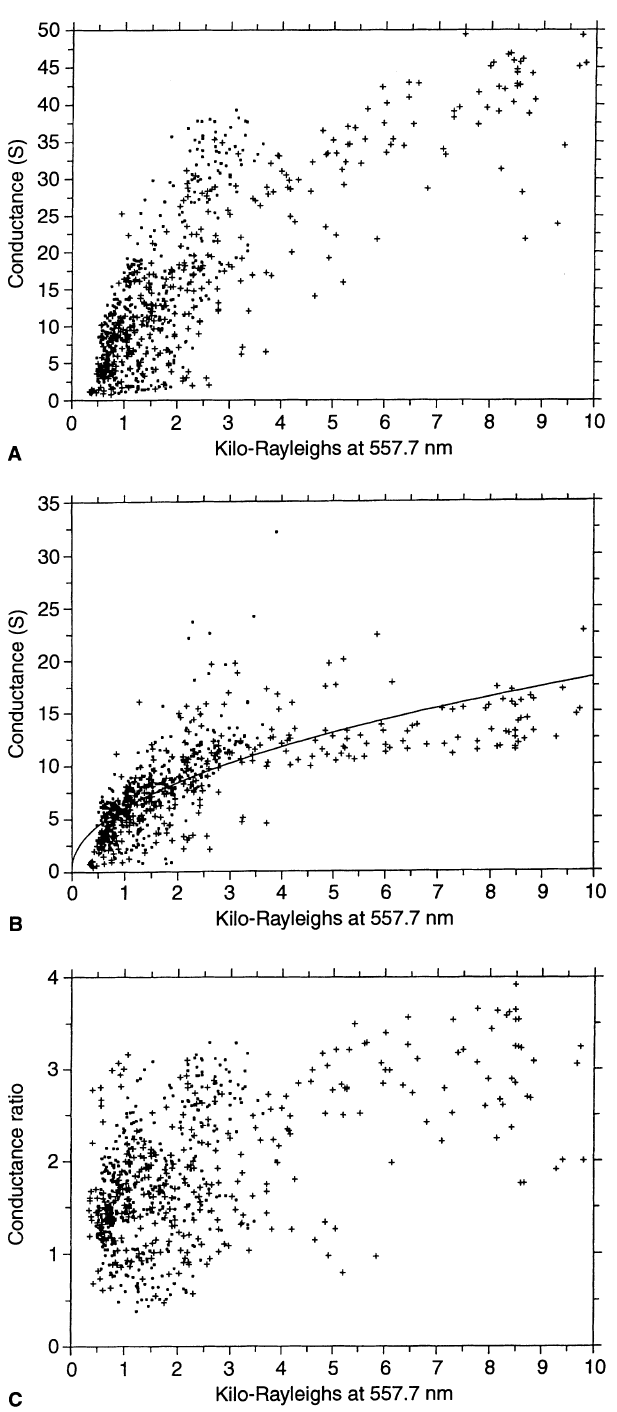
Table 1. The mean and standard deviation of Pedersen conduc- tance corresponding to the curve fit of Eq. (6), shown in the scatter plot of Fig. 2B, for di(cid:128)erent auroral intensity ranges Intensity range Fig. 2A–C. Scatter plots of conductance versus optical intensity at 557.7 nm. A is the Hall component, B the Pedersen component with least-squares curve fit of Eq. (4) and C the Hall to Pedersen ratio. Solid squares correspond to data for K < 4 whereas crosses are for p K (cid:179) 4 p